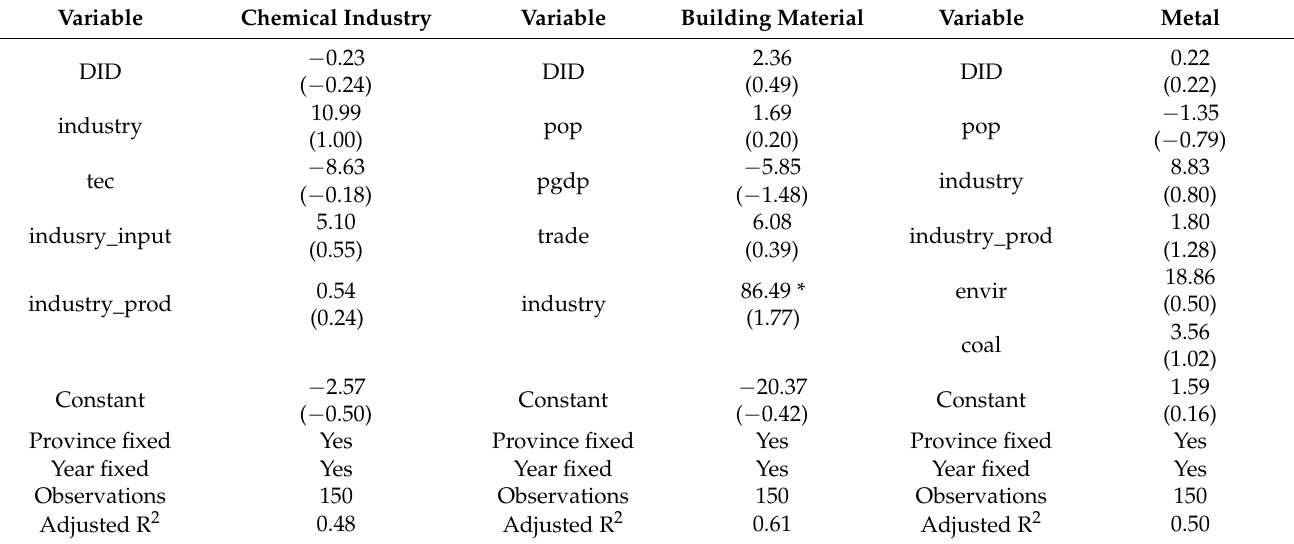
Table 5. Placebo test results of consumption-based carbon emission